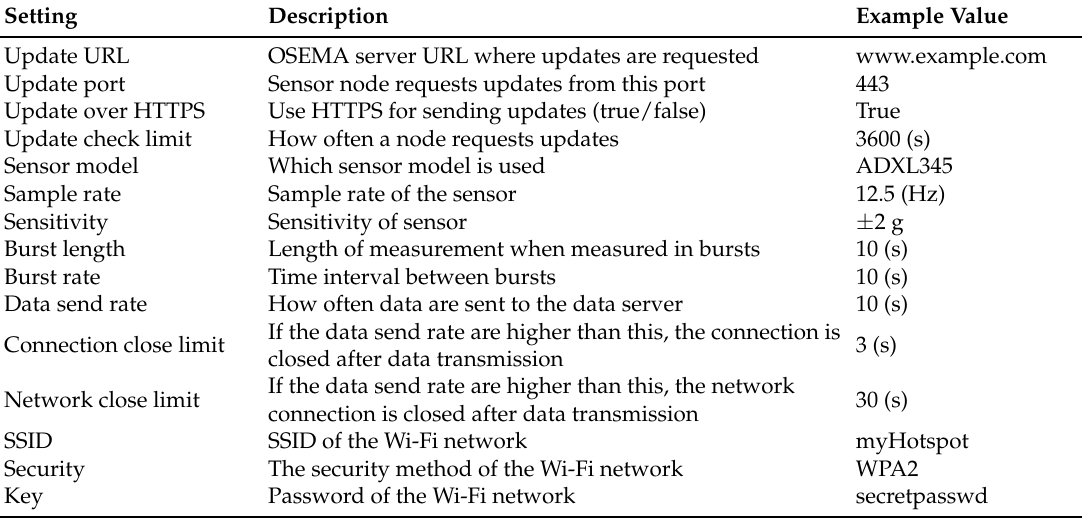
Table 1. Configurable settings of sensor nodes (updated version from